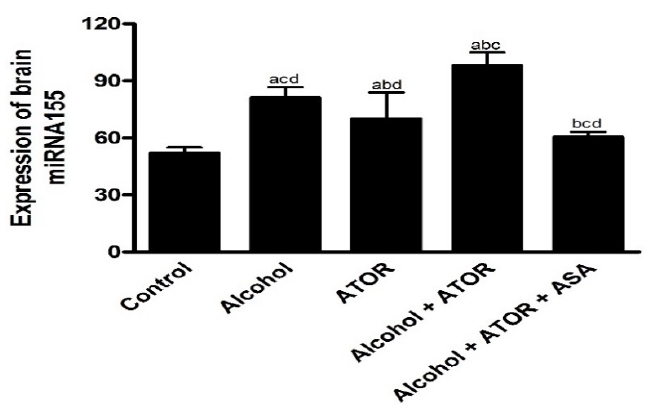
Figure 1. Expression of brain miRNA155 in the different treated groups (mean ± SD). Data are mean ± SD of 6 rats per group. p < 0.05 is significant; a p versus control group, b p versus Alcohol group, c p versus ATOR group, d p versus Alcohol + ATOR + ASA group.